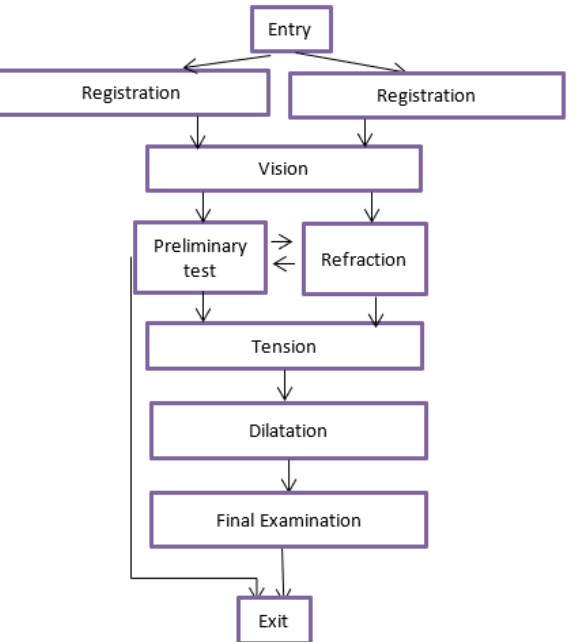
Figure 1. Outpatient clinic workflow of Aravind Eye OPC (created based on observations).